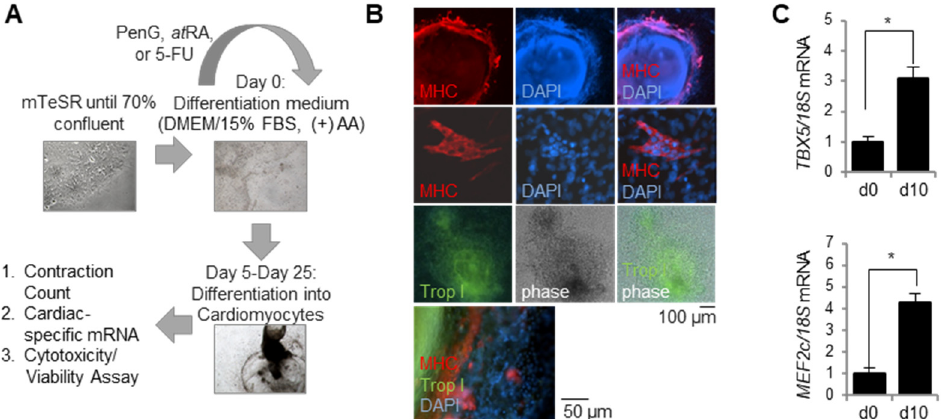
Figure 1. hiPSCs consistently and robustly differentiated into cardiomyocytes. Differentiated cardiomyocytes were assessed for cardiomyocyte-specific markers and gene expression. ( A ) Schematic protocol for cardiomyocyte differentiation and embryotoxicity screen. ( B ) Immunocytochemistry stains of differentiated cultures confirmed cardiomyocyte identity via myosin heavy chain (MHC) and Troponin I (Trop I). ( C ) Differentiated cardiomyocytes expressed cardiac-specific genes TBX5 and MEF2c as measured by qPCR, n = 3 biological replicates ± SD, * p < 0.05, Student’s t -test. hiPSC, human induced pluripotent stem cell; MHC, myosin heavy chain; Trop I, Troponin I.